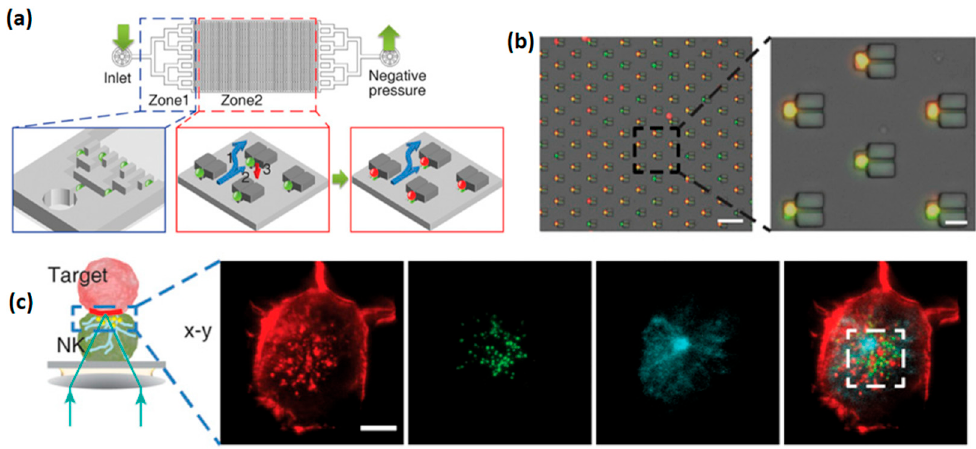
Figure 8. Microfluidic well arrays with microtraps for NK cells. ( a ) Scheme of the microfluidic device ( b ) Merged bright file and fluorescent images after the cell loading into the device; ( b ) red and green channels correspond to K562 and KHYG-1 cells, respectively. Scale bar, 100 µm (left) and 20 µm (right). ( c ) Immune synapse imaged by confocal microscopy at the interface of vertically stacked of NK—target cell pair. The cells are fixed, permeabilized, and stained for F-actin (red), perforin (green), and alfa-tubulin (cyan). Scale bars: 5 µm. Reproduced with permission from Reference [65].